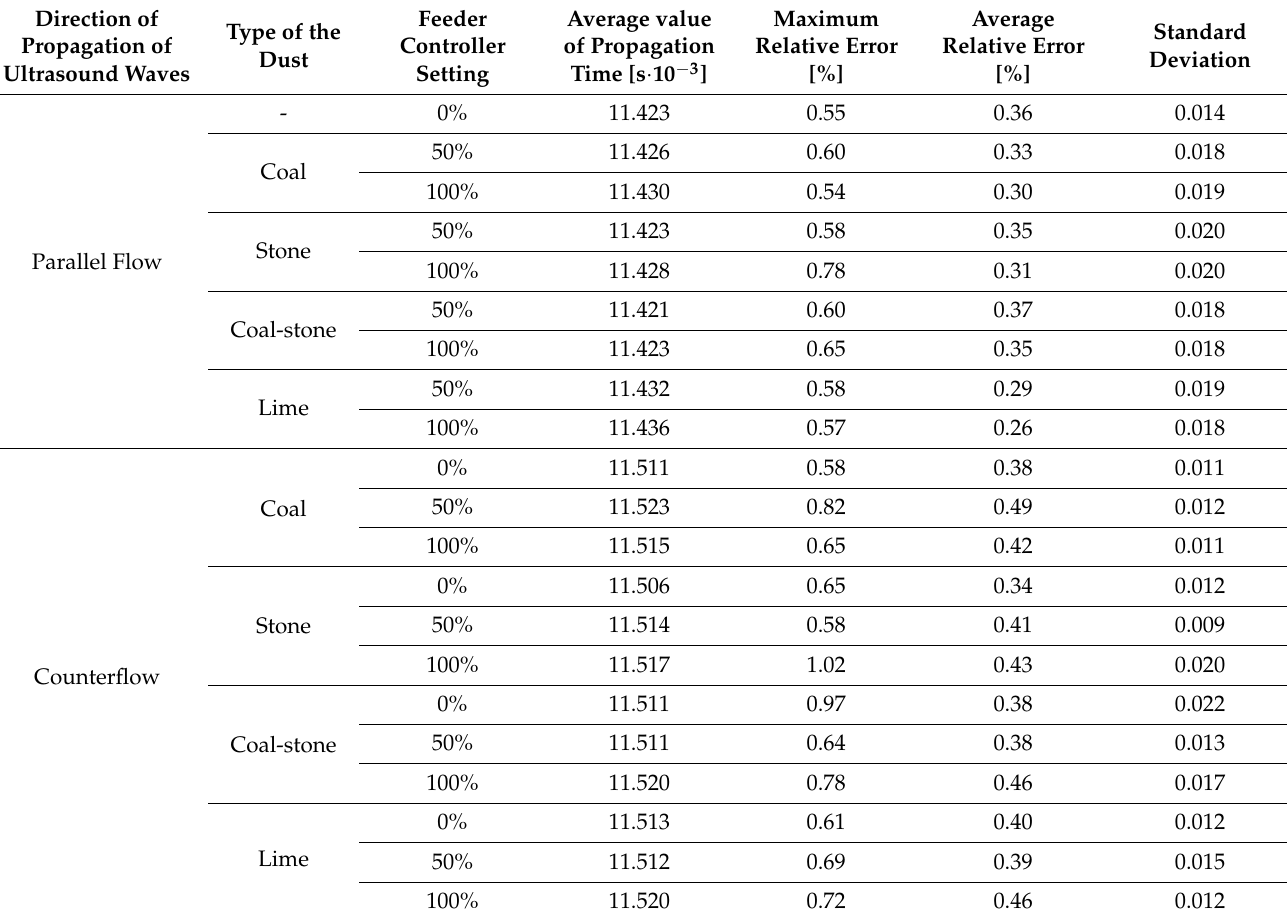
Table 4. Values of errors and uncertainties in measuring the propagation time of ultrasonic